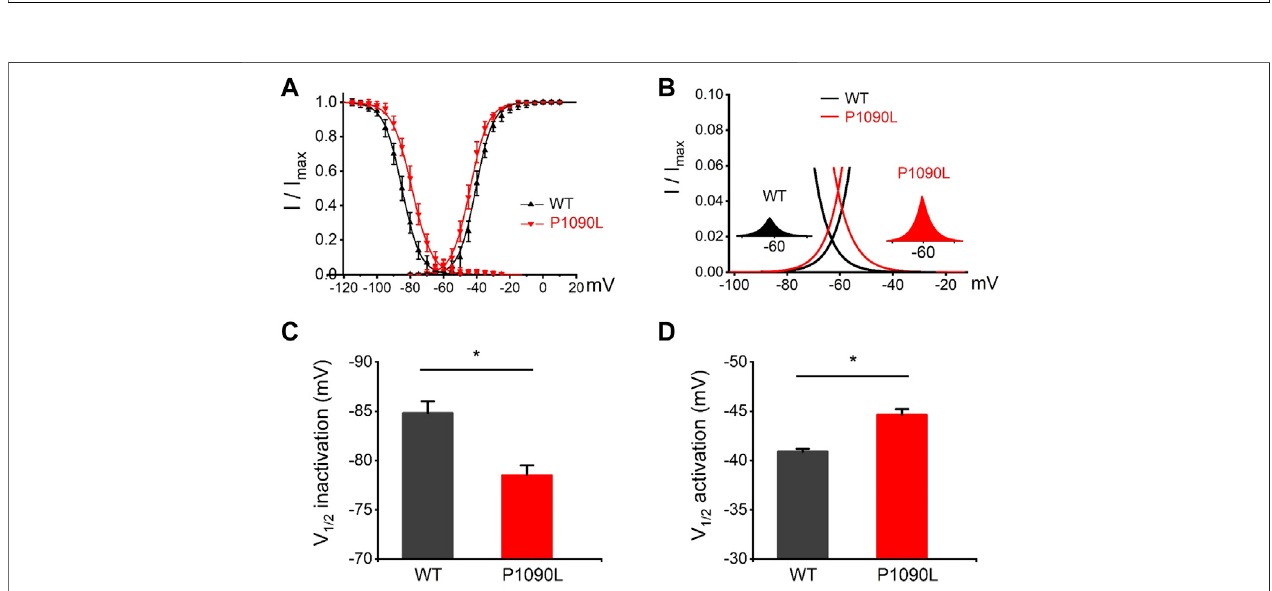
FIGURE2| EffectsofP1090L mutation onvoltage-dependentgating ofthe Na v 1.5channel. (A) .Steady-state activationand inactivation curves ofNa v 1.5WT and P1090L mutation. Inactivation currents were elicited to − 20 mV following prepulses between − 120 and − 20 mV in 5 mV steps for 500 ms. Activation currents were measured from a holding potential of − 120 mV to test potentials ranging between − 110 and +20 mV in 5 mV steps. Curves are Boltzmann fi ts of the data points ( n = 8). (B) . The view of the overlapping area between activation and steady-state inactivation was expanded from (A) . Left inset shows sodium window current of WT Na v 1.5 channel (black). Right inset shows sodium window current of P1090L mutation (red). (C) . Summary of V 1/2 of steady-state inactivation for WT and P1090L channel. (D) . Summary of V 1/2 of voltage-dependent activation for WT and P1090L channel. Data are presented as the mean ± SEM. * p < 0.05.